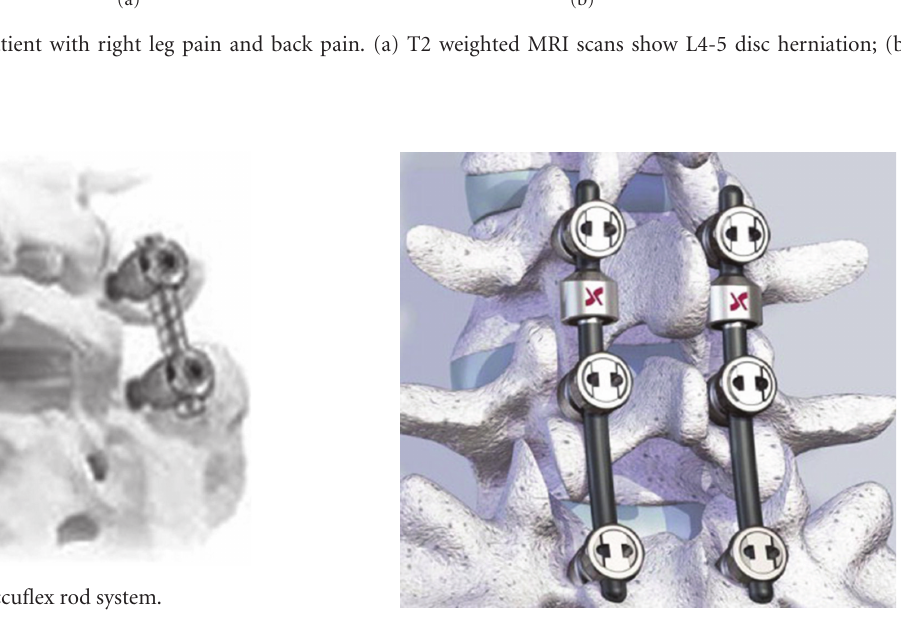
Figure 5: The Isobar TTL